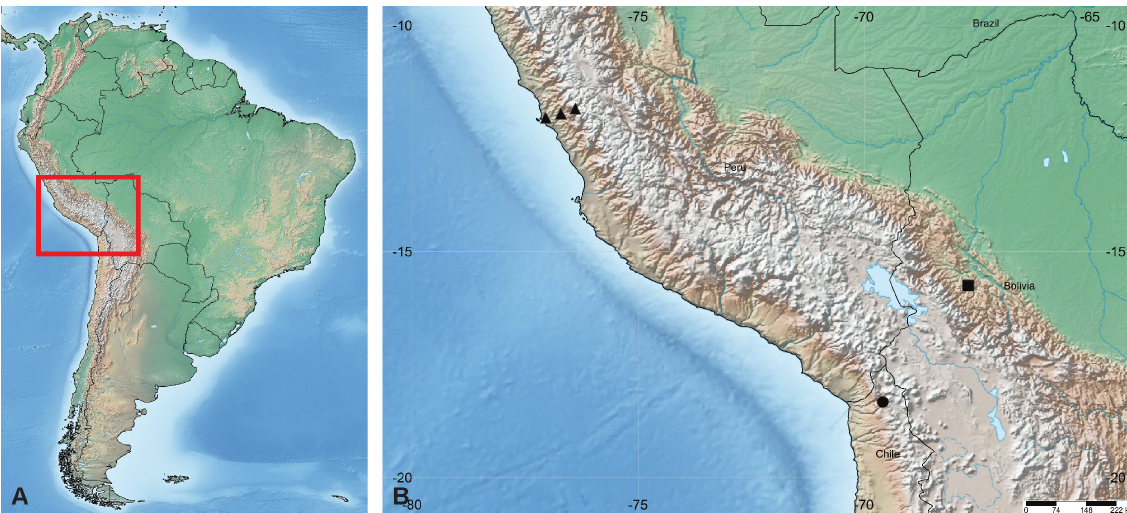
Fig. 8. Geographic distribution of three Neotropical Heliodinidae. Red rectangle on left indicates the location in South America of the area enlarged on right. Circle = type locality of Helioandesia tarregai gen. et sp. nov. in northern Chile. Triangles = distribution of Aetole demarcha (Meyrick, 1917), the geographically nearest heliodinid species to H. tarregai gen. et sp. nov. on the western slopes of the Andes, in Peru. Square = type locality of Lithariapteryx loriculata (Meyrick, 1932) on the eastern slopes of the Andes of Bolivia, the morphologically nearest species to H. tarregai gen. et sp.